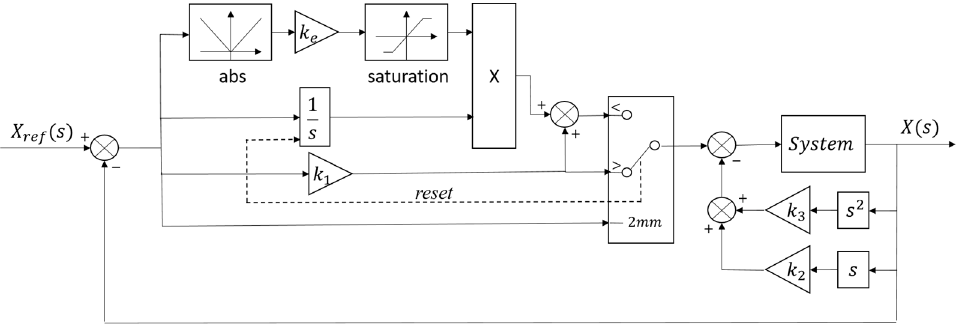
Figure 9. Block diagram of the SFC+I M controller.